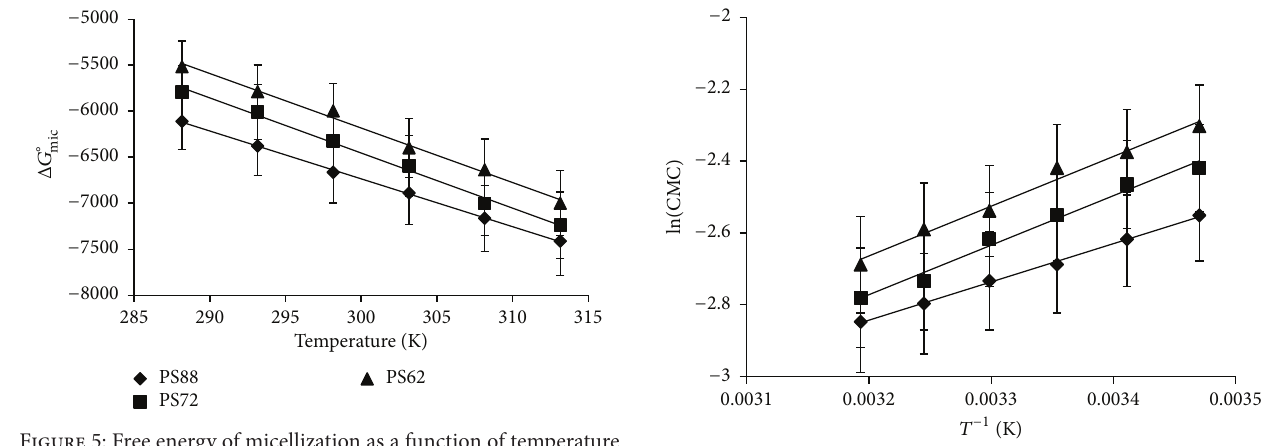
Figure 5: Free energy of micellization as a function of temperature for all the three polymer samples.